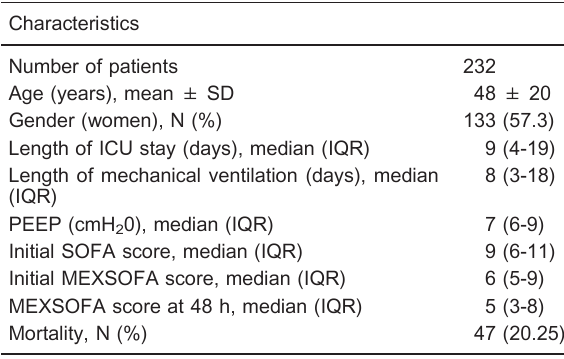
Table 2. Demographic and clinical characteristics of the study